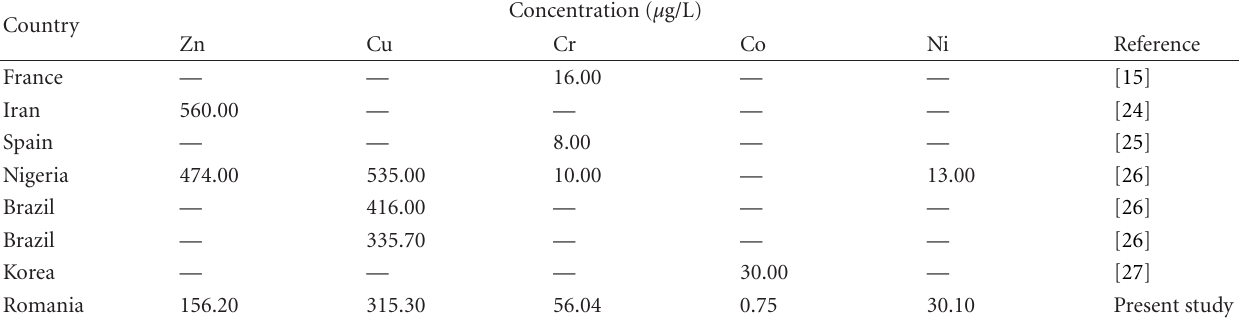
Table 3: Elemental composition of fruit juice among di ff erent countries versus elemental composition of Romanian apple juices.